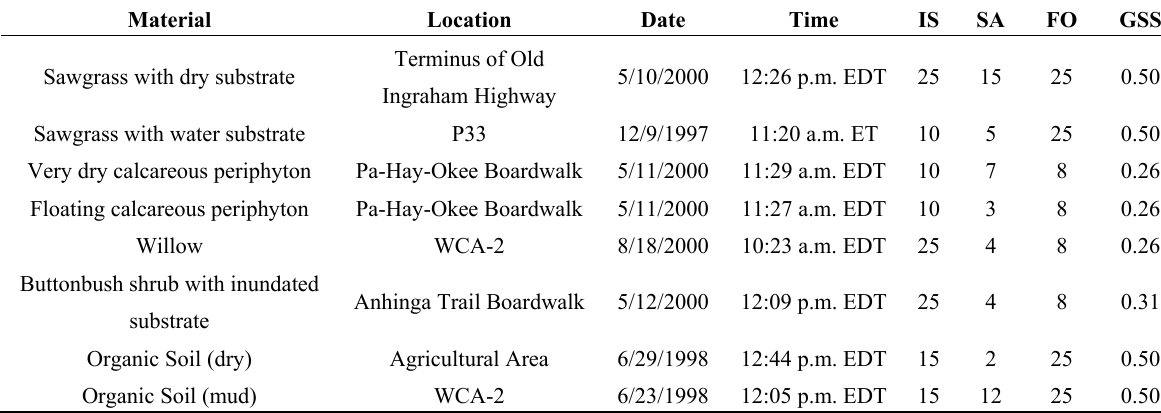
Table 2. Characteristics of spectra shown in Figures 2 and 3. Location = description of general locations where spectra were collected. IS = number of spectra integrated to produce a single spectra example. SA = number of different spectra examples averaged to create the representative spectra of that cover type. FO = fore-optic used (degrees). GSS = approximate ground spot size (m) for each